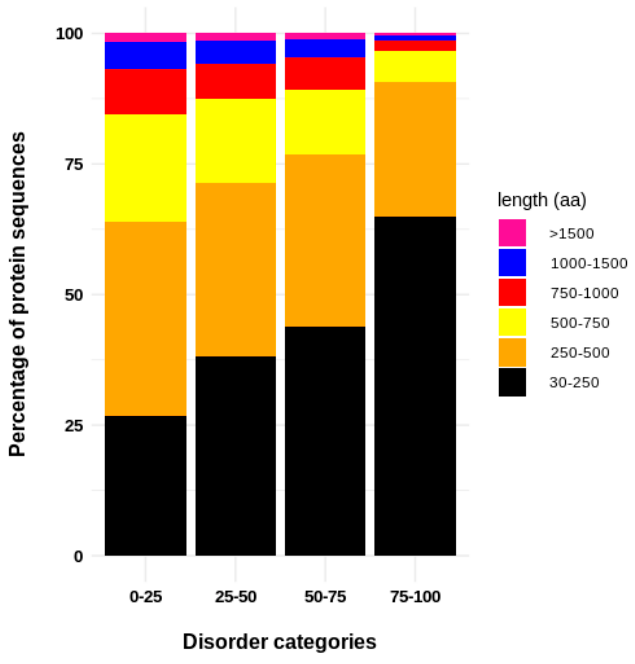
Figure 1. Relationship between the level of disorder and the protein length. It can be observed that the more disordered the proteins, the greater the relative proportion of smaller sized proteins constituting each category.